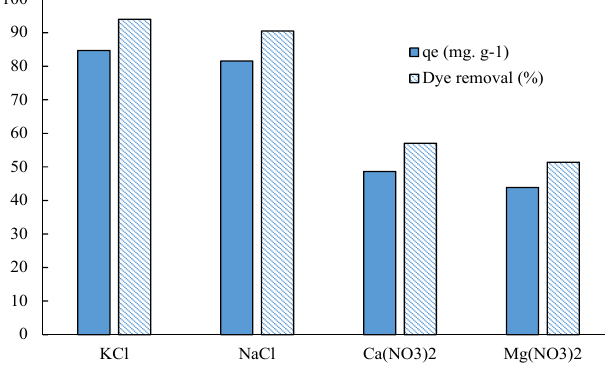
Fig. 10: Effect of various salt on MB adsorption by Fe